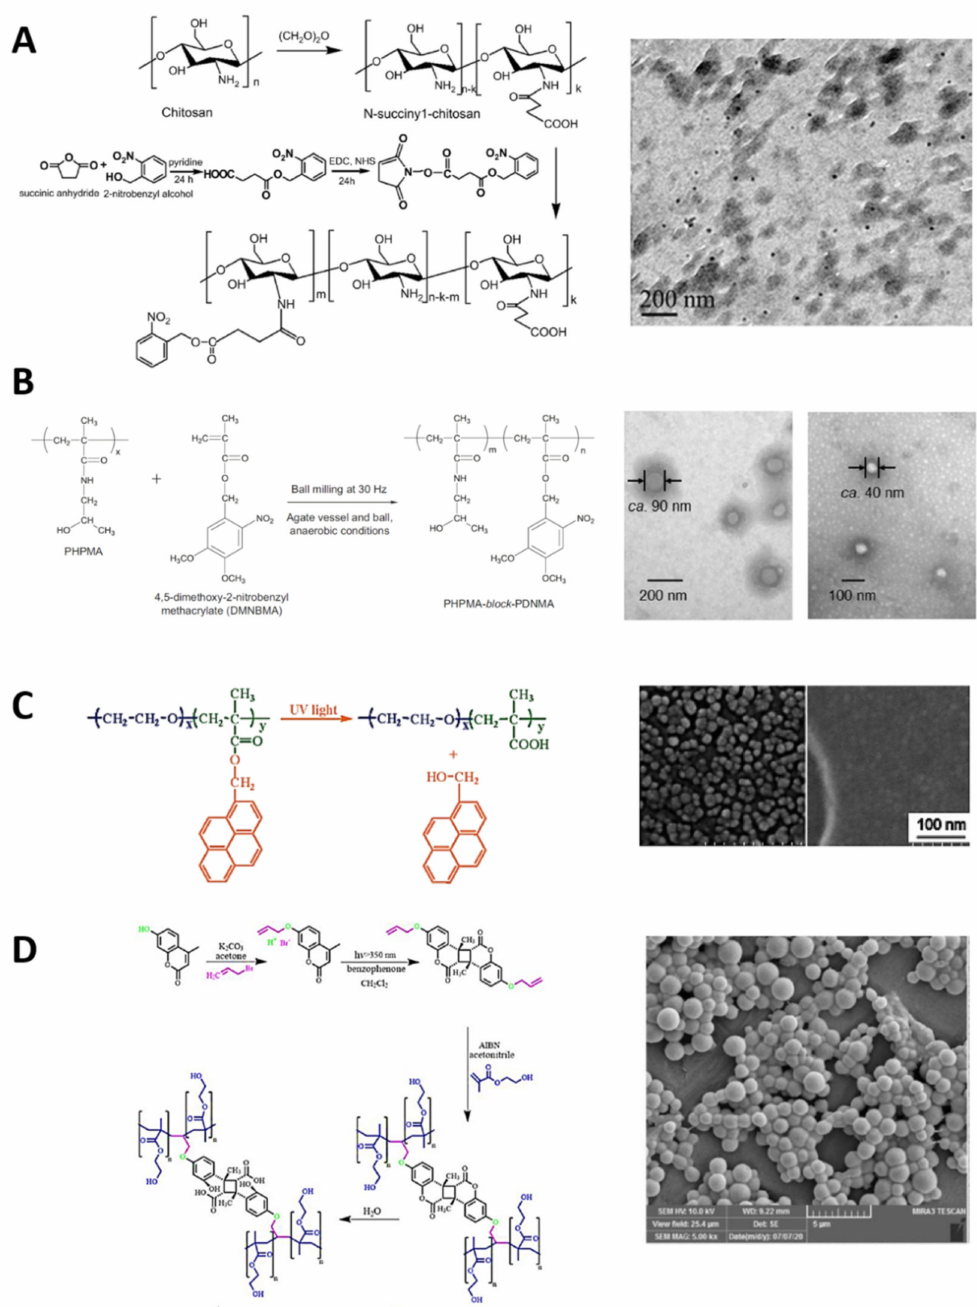
Figure 4. Schematic synthetic route (left) and TEM images (right) of the corresponding UV–NIR photocleavable polymers and carriers. ( A ) o-nitrobenzyl APNSC, ( B ) o-nitrobenzyl PHPMA, ( C ) pyrenylmethyl ester, and ( D ) coumarinyl ester copolymers, respectively. Reprinted with permission from [149–152], Copyright 2013, Elsevier, 2020 Springer Nature, 2005 American Chemical Society, and 2021,